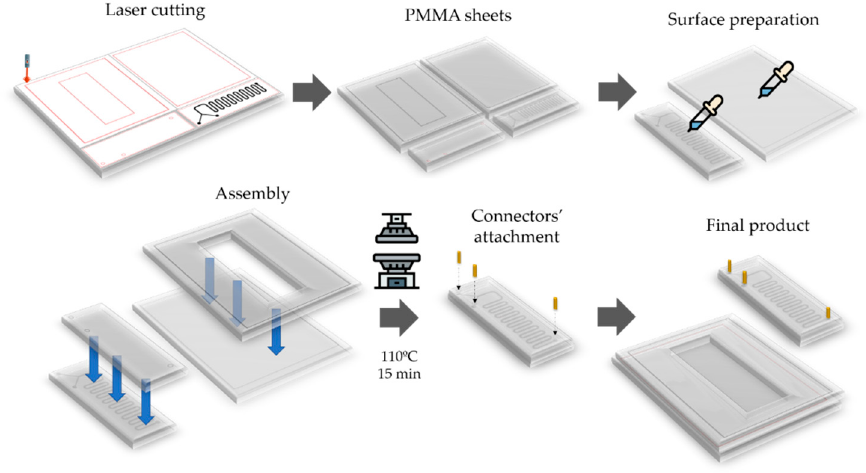
Figure 2. Schematic representation of the microfluidic device and baseplate manufacturing